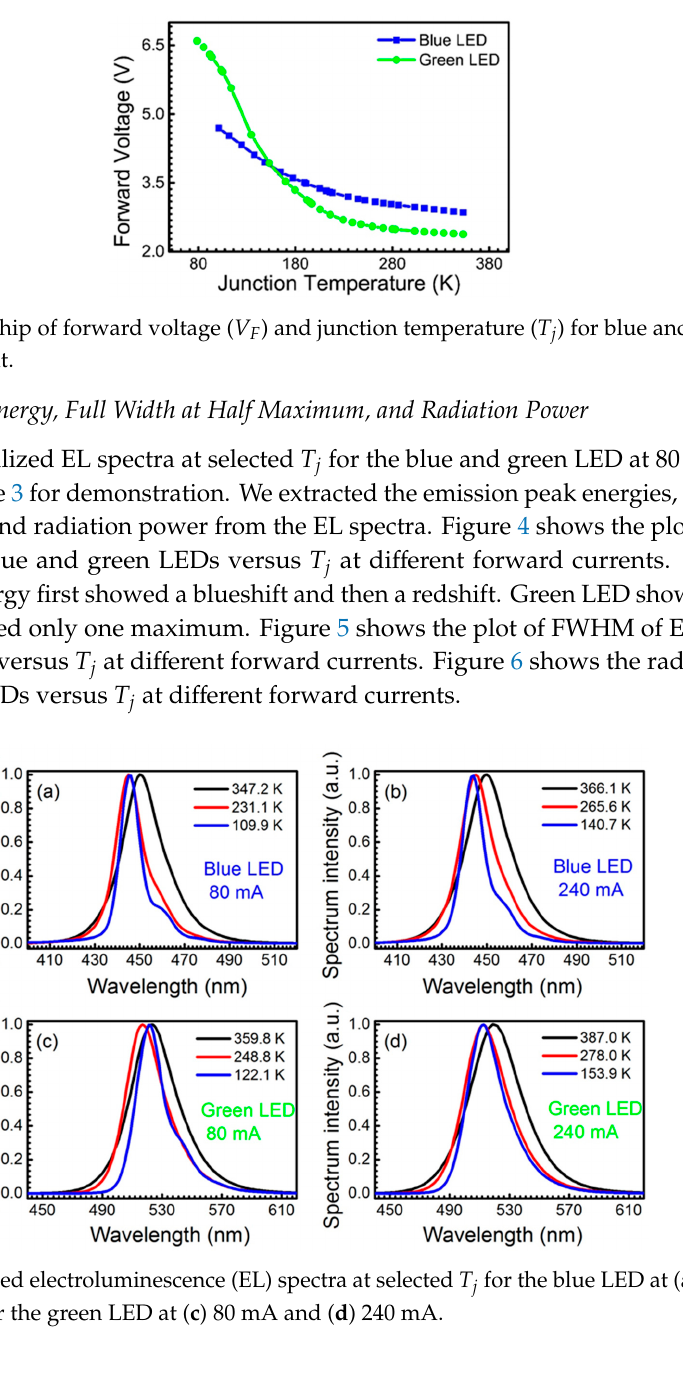
Figure 4. Relationship between the emission peak energy and T j for the ( a ) blue LED and ( b ) green LED. Figure 5. Relationship between the full width at half maximum (FWHM) of the EL spectra and T j for the ( a ) blue LED and ( b ) green LED.